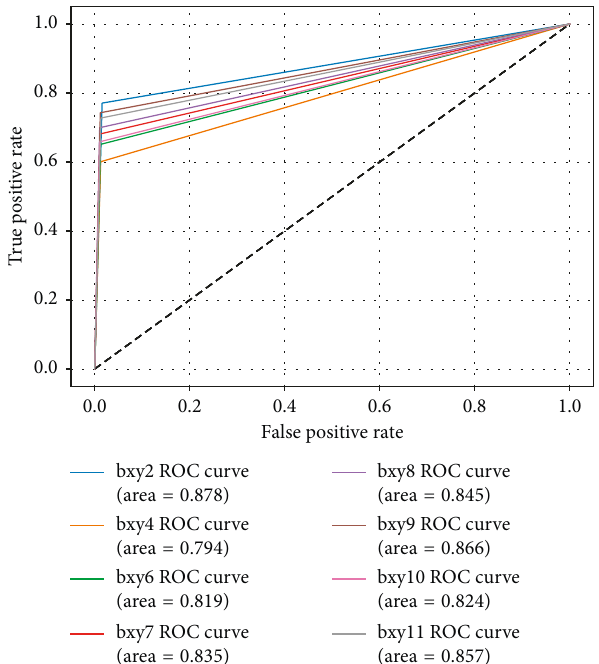
Figure 12: ROC curves of BCM crack detection results.